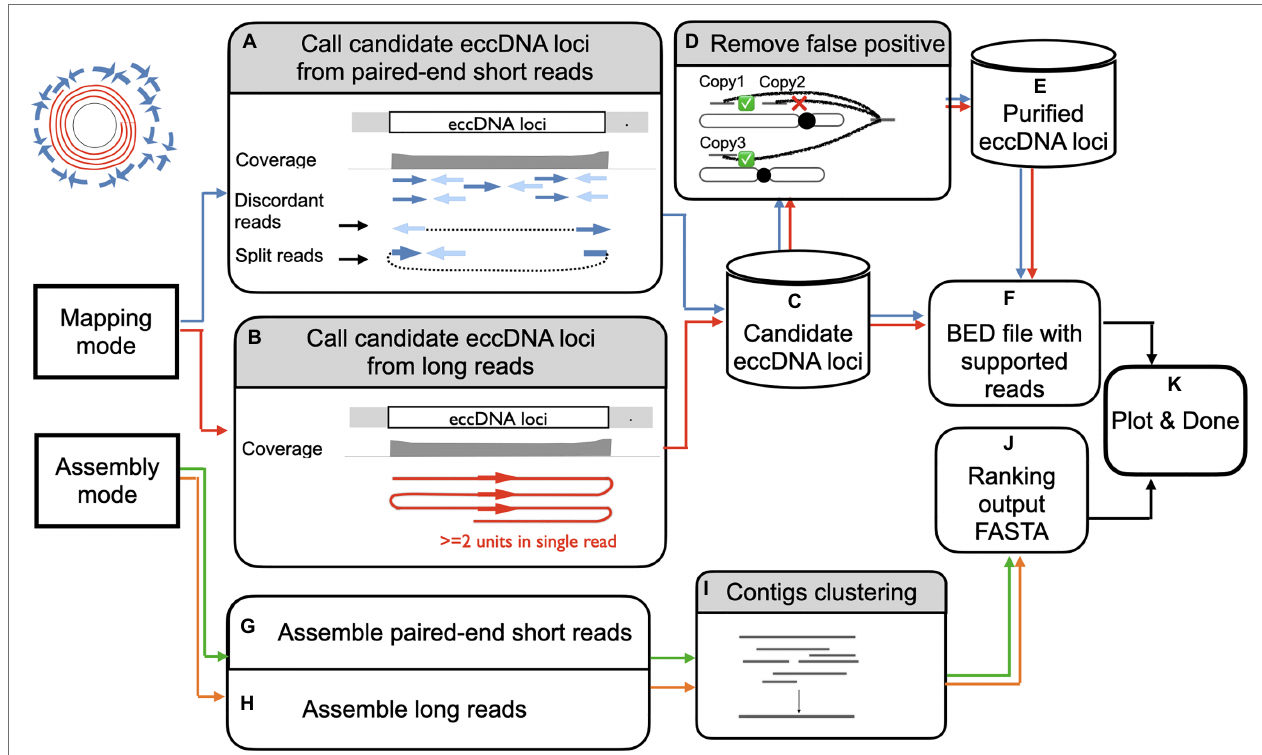
FIGURE 2 | Overview of eccDNA detection using ecc_finder. ecc_finder identifies eccDNA loci from illumina paired -end short reads (SR, blue/green ) or Nanopore long reads (LR, red/orange) with or without a reference genome. In mapping mode, ecc_finder filters discordant and split reads detected from SR ( A , blue ), and filters for more than 2 junctions in a single read from LR ( B , red ), the reference genome being provided by the user. Using these filtered reads together with the covergae information, ecc_finder establishes a list of eccDNA candidates (C) . ecc_finder further detects false positive eccDNAs originating from repeated loci (D,E) . The bed output of a sample is further normalized (F) to append multiple samples to create a heat map (K) . In assembly mode, ecc_finder assembles SR with a k-mer assembler ( G , green ), and/or assembles LR using a repeat unit recognition algorithm ( H , orange ). The contigs are then clustered based on highly similarity (I) . The output is a fasta file indicating the number of supported reads for each contig (J) . Both mapping and assembling mode can be run in parallel to generate a heat map (K)